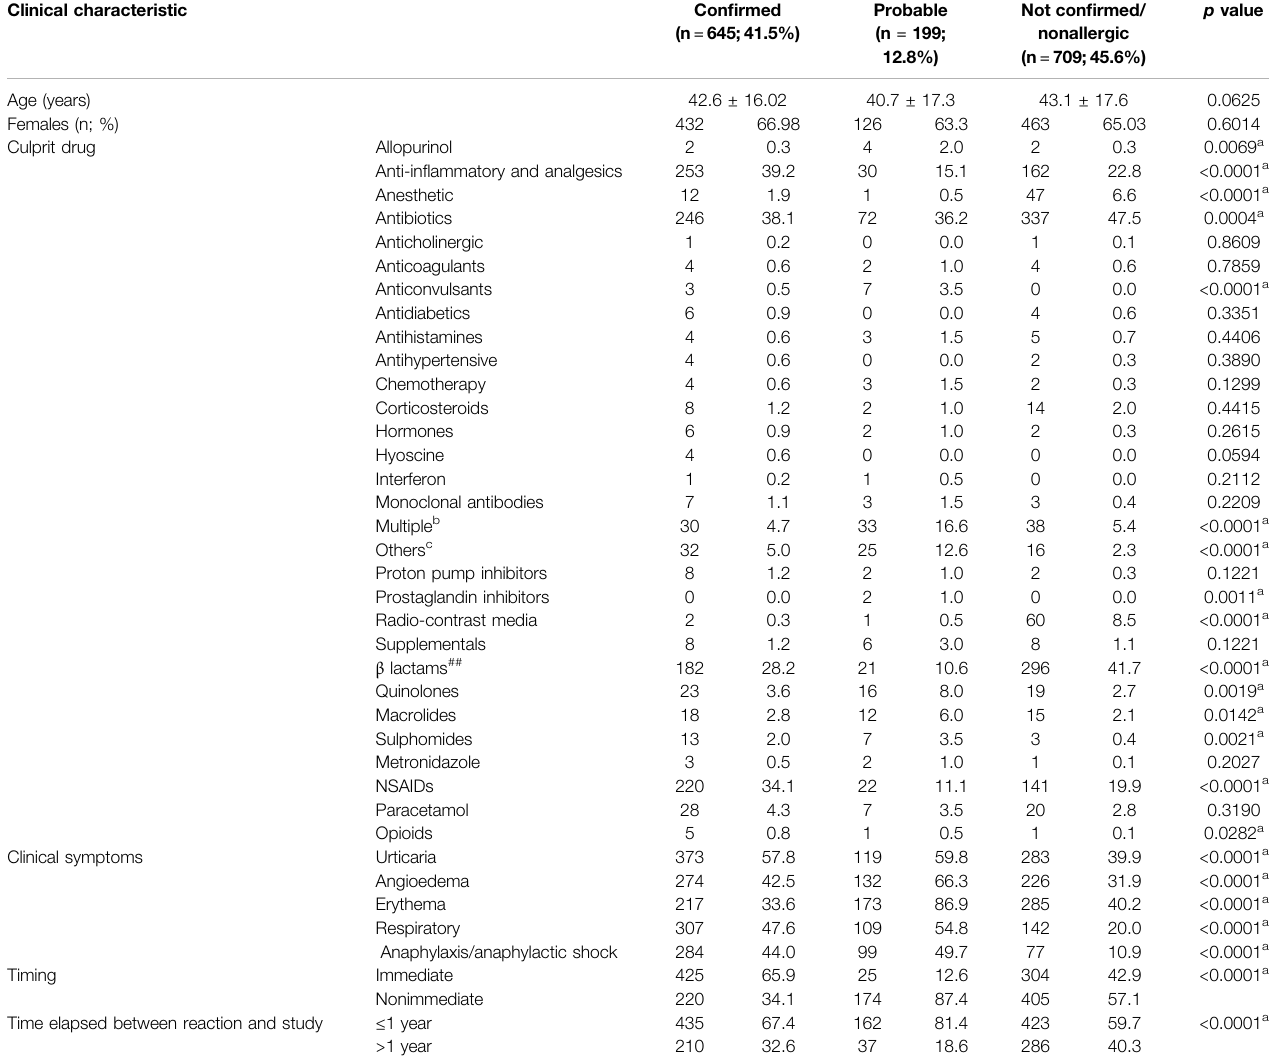
TABLE 2 | Clinical characteristics among patients with con fi rmed and not con fi rmed/nonallergic. Clinical characteristic Con fi rmed